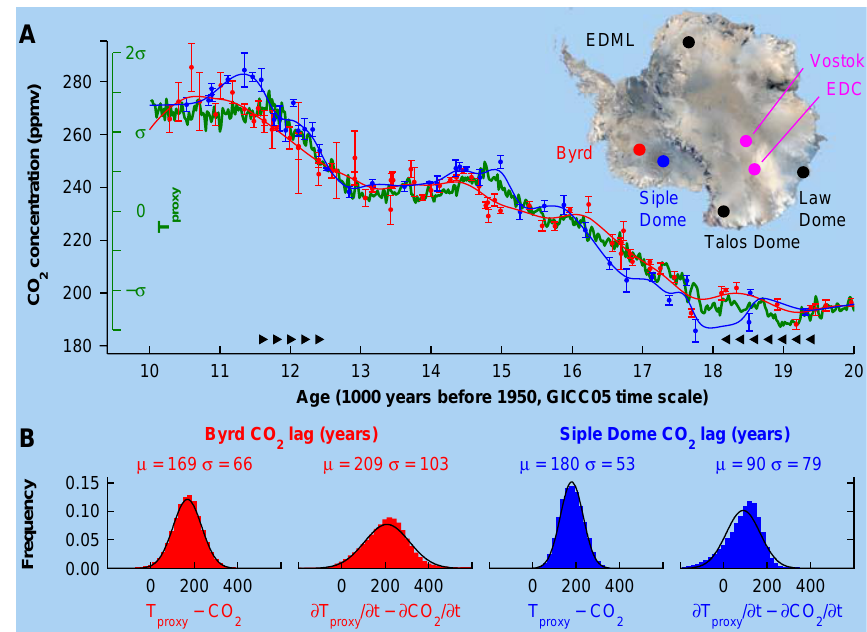
Fig. 1. The phase relationship between regional Antarctic temperature and atmospheric CO 2 . (A) Antarctic temperature proxy T proxy (green) and CO 2 data (1 σ error bars) from Byrd (red) and Siple Dome (blue) on the GICC05 timescale. In the example shown, the CO 2 curves have been smoothed with a Gaussian filter of width 105yr. (B) Lag histograms for the two lag determination techniques (direct correlation and correlation of derivatives) using each of the two CO 2 data sets (red, blue) and the best fit of Gaussian distributions (black curves and µ and σ values). The histogram widths reflect each lag determination’s sensitivity to the degree of data smoothing, CO 2 measurement uncertainties, and different choices of lag calculation data interval start and end points (black triangles in part (A) ). The map shows the location of the Antarctic ice core sites mentioned in the text (source: